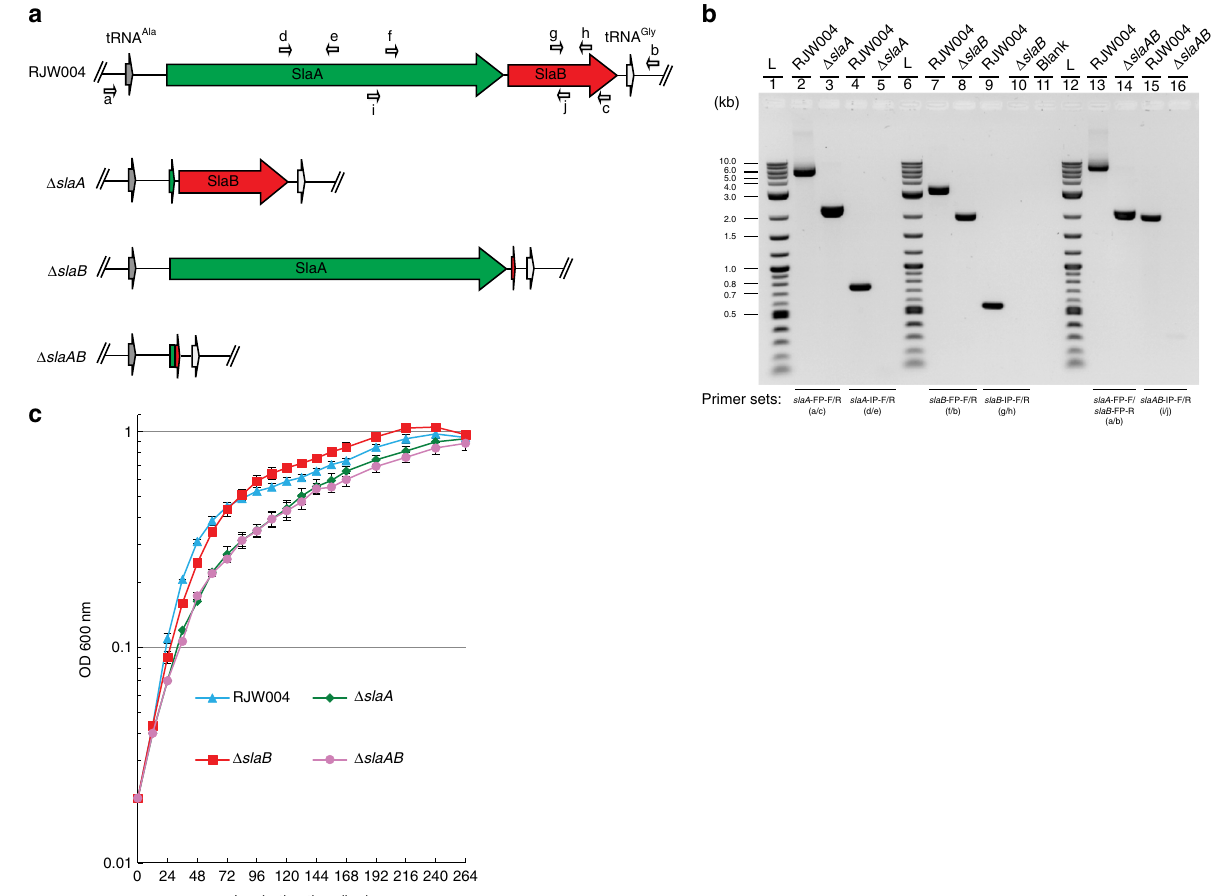
Fig. 3 S-layer genes are not essential for the S. islandicus cell survival. a Genomic context of S-layer genes in the genetic host and mutant strains. Relative positions of primers used to con fi rm S-layer gene deletions are labelled with small arrows. b PCR veri fi cation of Δ slaA , Δ slaB , and Δ slaAB mutants with two primer sets, which bind the fl anking and internal regions of S-layer genes, respectively. Expected sizes of amplicons can be found in Supplementary Table 8. L (lanes 1, 6, and 12) indicates the 2-Log DNA Ladder (NEB, USA). Blank (lane 11) denotes that no sample was loaded in the well. c Growth pro fi les of RJW004 (wild type), Δ slaA , Δ slaB , and Δ slaAB mutant strains. Wild-type and S-layer gene knockout strains were cultivated at pH 3.3, 76 °C for 11 days in DY liquid medium supplemented with uracil and agmatine without shaking. Cell culture growth was monitored by optical density measurements at 600 nm every 12 or 24 h. Error bars represented standard deviations from three independent